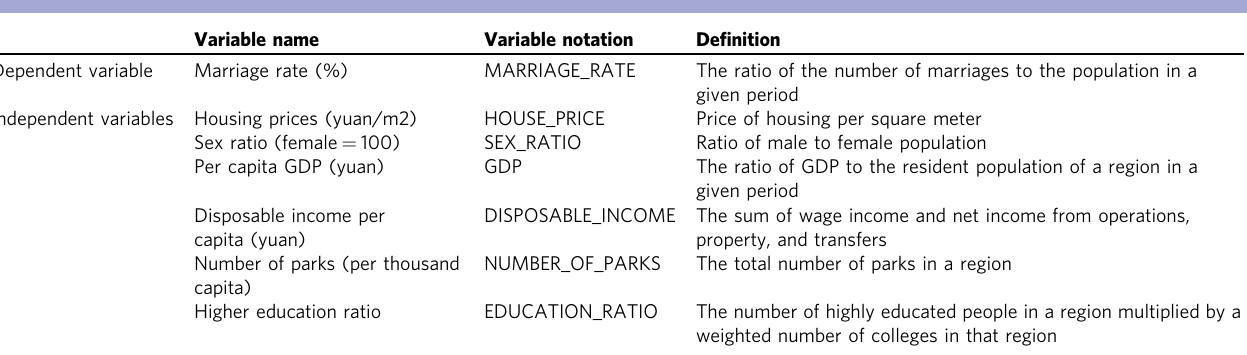
Table 1 Variable names and de fi